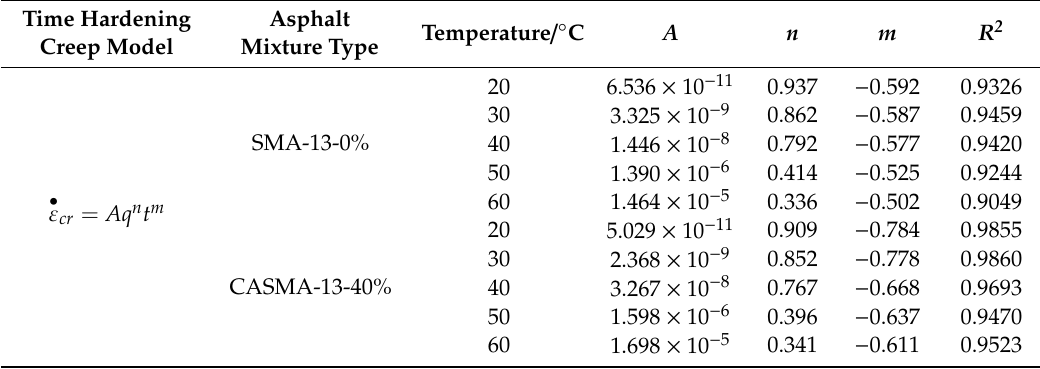
Table 6. Creep parameters of surface course.